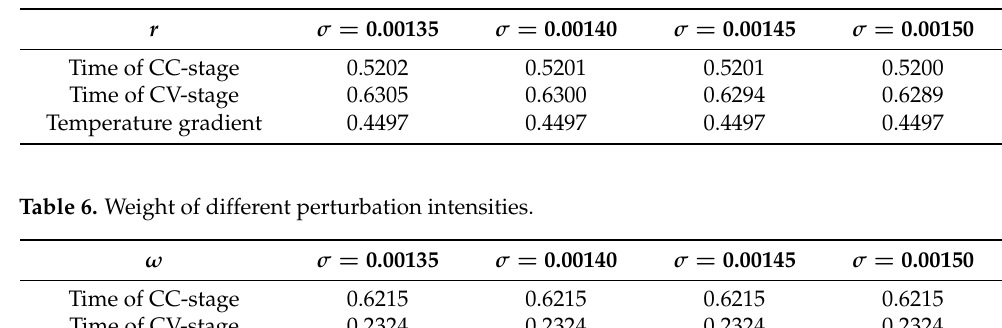
Figure 16. Expected utility of lithium-ion battery performance. Table 5. Reliability of different perturbation intensities.